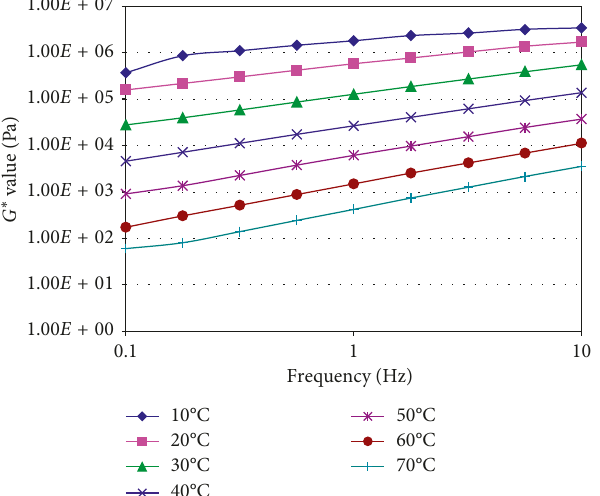
Figure 16: G value versus loading frequency for the limestone mastic (VR ∗ (cid:30)